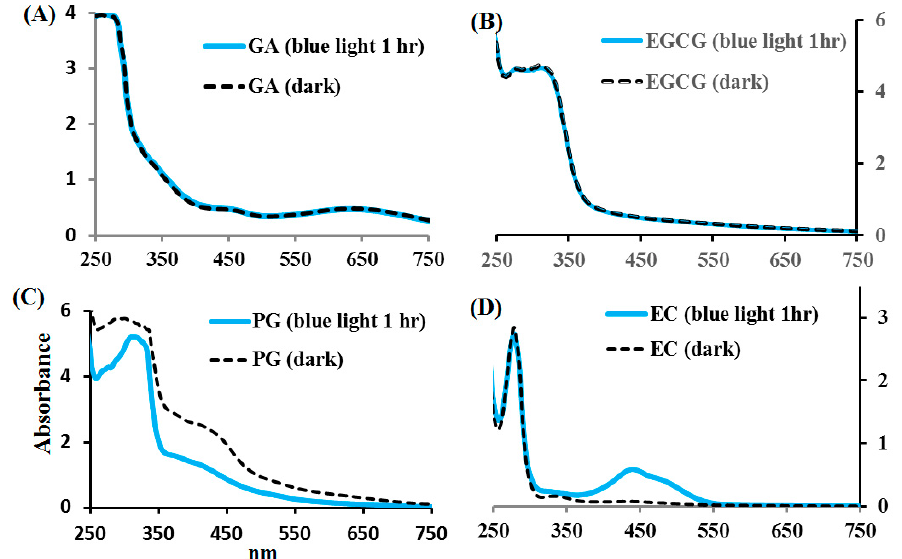
Figure 4. The absorption spectra of ( A ) GA, ( B ) EGCG, ( C ) PG, and ( D ) EC in phosphate buffer solution at pH 8.0, illuminated by blue light at 2.0 mW/cm 2 for 1 h. The absorbance of the reaction solutions was measured within the spectral range from 250 to 750 nm.